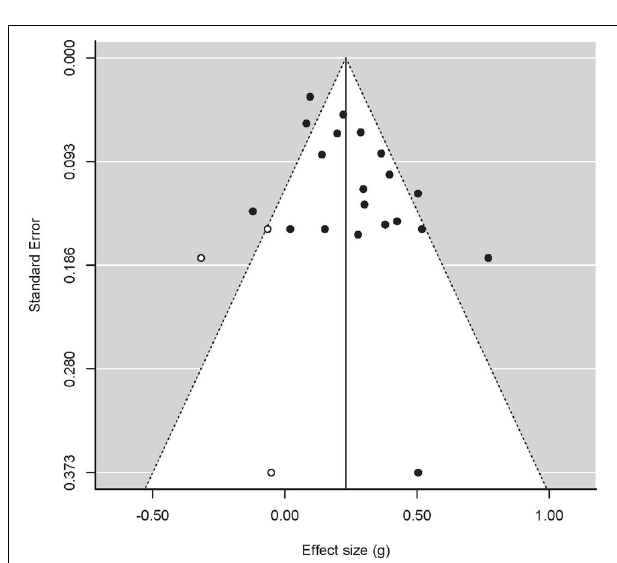
FIGURE 2 | Funnel plot for studies concerning Negative Affect, with treatment effects on the x-axis and the standard error on the y-axis. Closed circles are original data, open circles represent filled-in data based on the trim-and-fill method. Dotted lines represent 95% confidence interval around the mean.